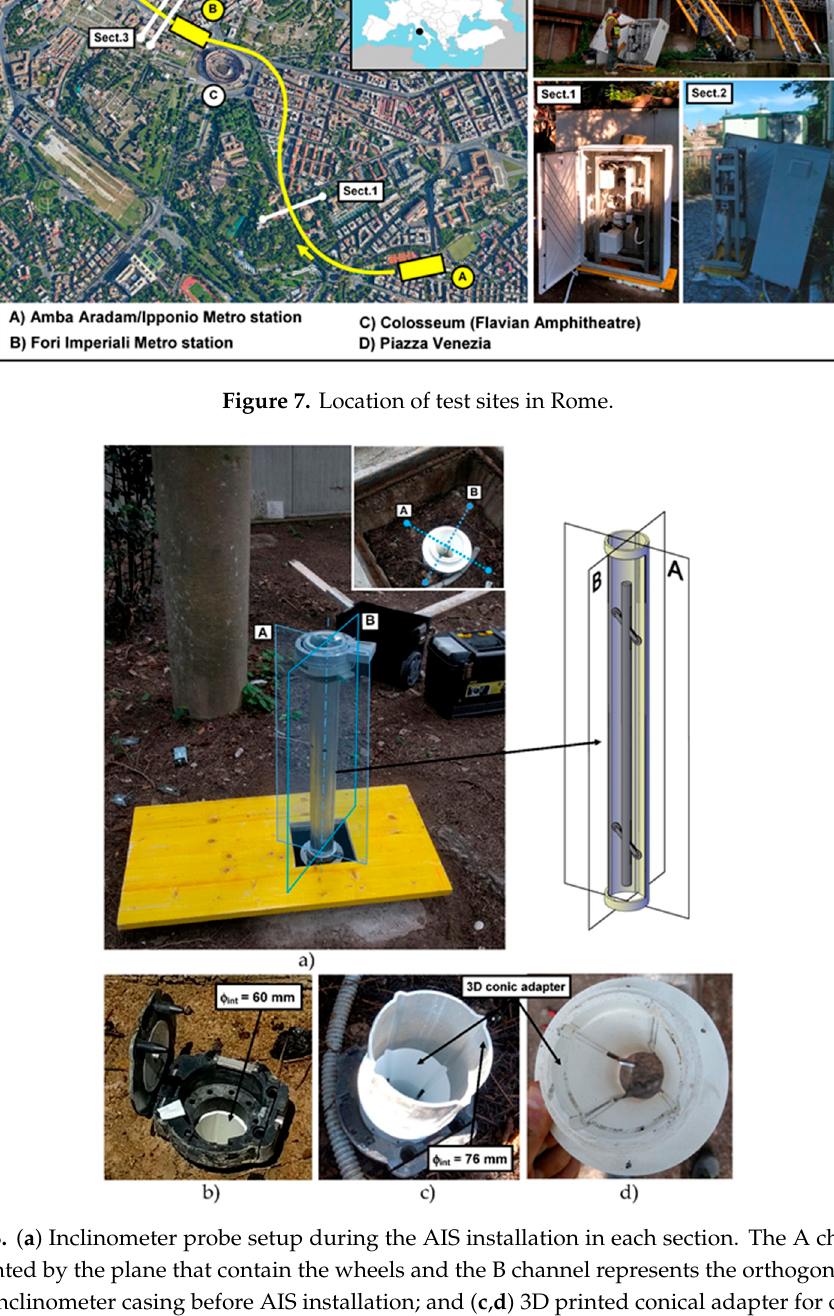
Table 3. Type of graphs plotted for each borehole.